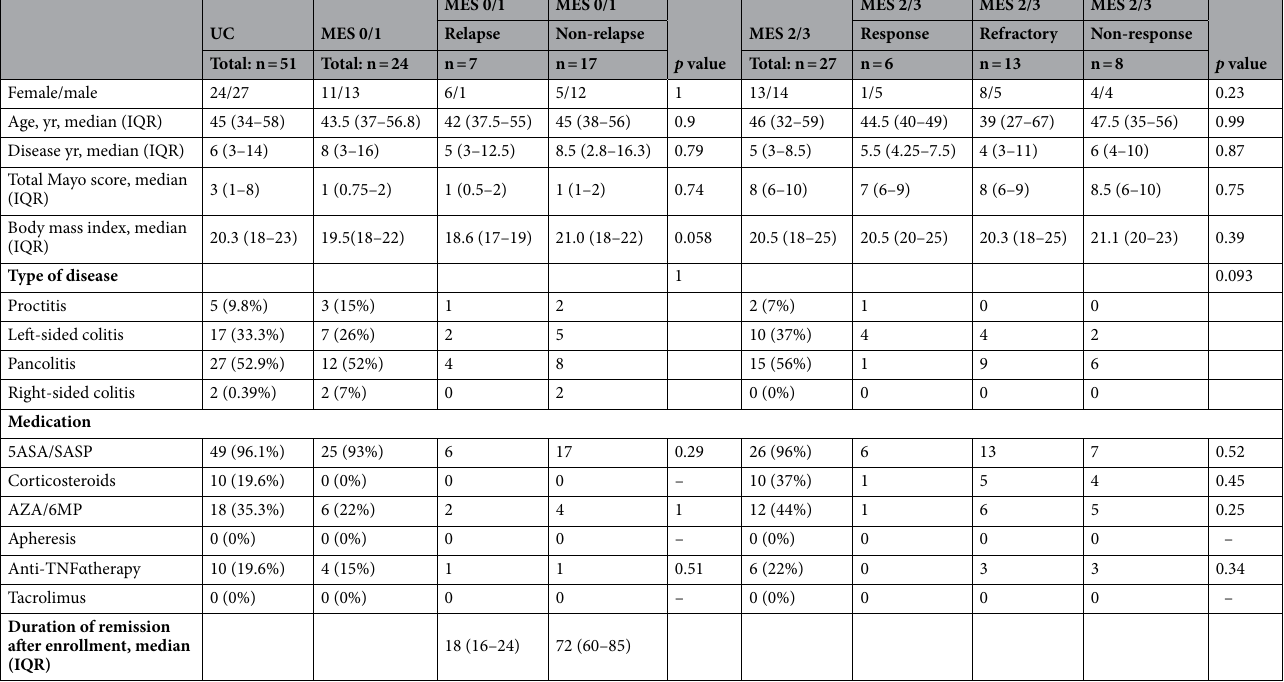
Table 1. Clinical Characteristics of Patients with UC at Enrollment. 5ASA 5-aminosalicylic acid, SASP salazosulfapyridine, AZA azathioprine, 6MP mercaptopurine, IQR interquartile range. p value: Fisher’s